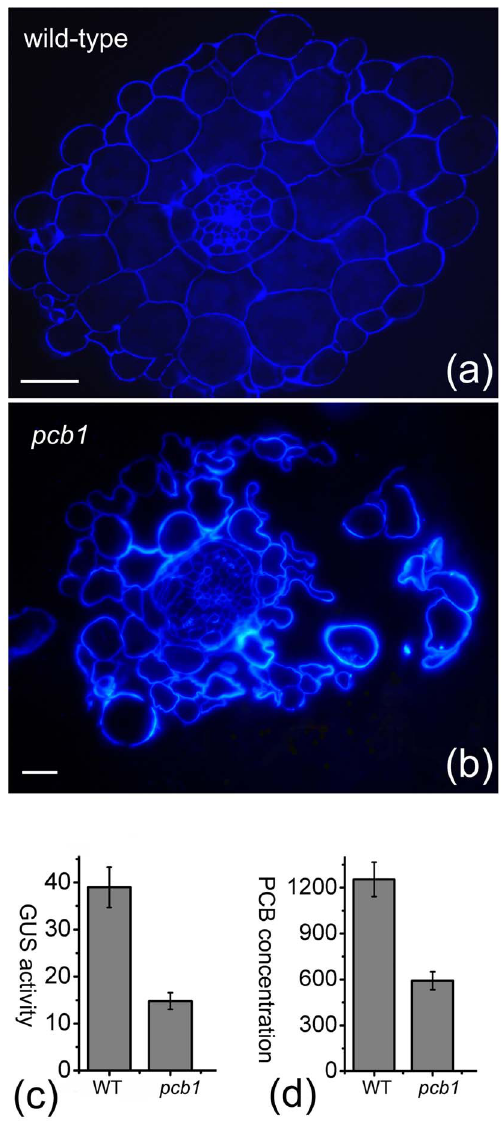
Figure 6. Reduced cell adhesion and PCB accumulation in the pcb1 mutant. (a) Cell wall staining in a transverse section of a wild- type root. (b) Cell wall staining in a transverse section of a pcb1 root showed dramatically reduced cell adhesion in epidermal, cortical and endodermal cells of roots. (c) GUS activity in the wild-type and the pcb1 mutant induced by PCB 18. (d) Comparison of PCB 18 accumulation in wild-type and pcb1 . Six-d-old Arabidopsis seedlings were transferred to plates containing 10 m M PCB 18 and grown for 6 d. Bars: 12.5 m m.